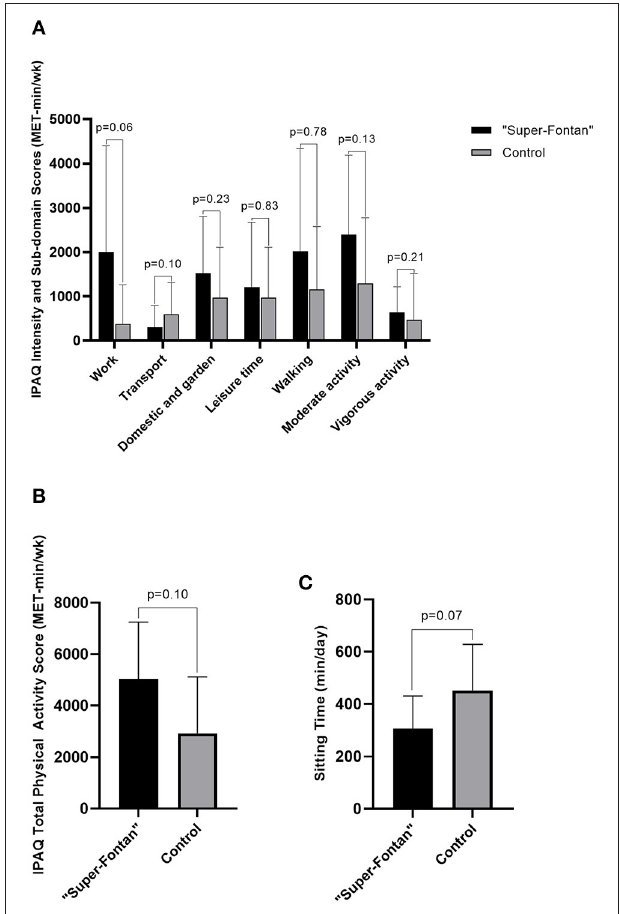
FIGURE 2 | International physical activity questionnaire (IPAQ) scores. (A) IPAQ intensity and sub-domain scores, (B) IPAQ total physical activity score, (C) Sitting time. Metabolic minutes per week (MET-min/wk); minutes per day